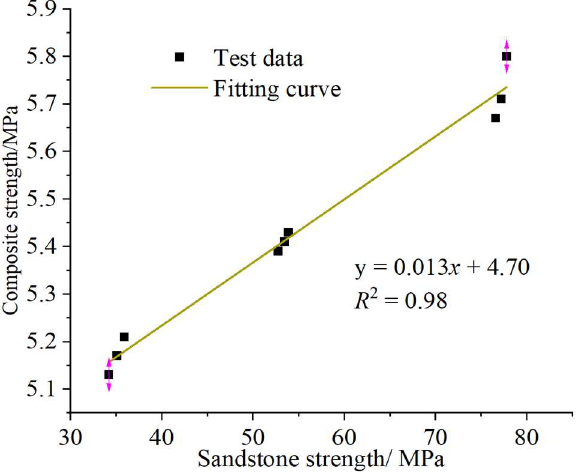
Figure 3. Effect of lithology on the strength of coal–rock assemblages.